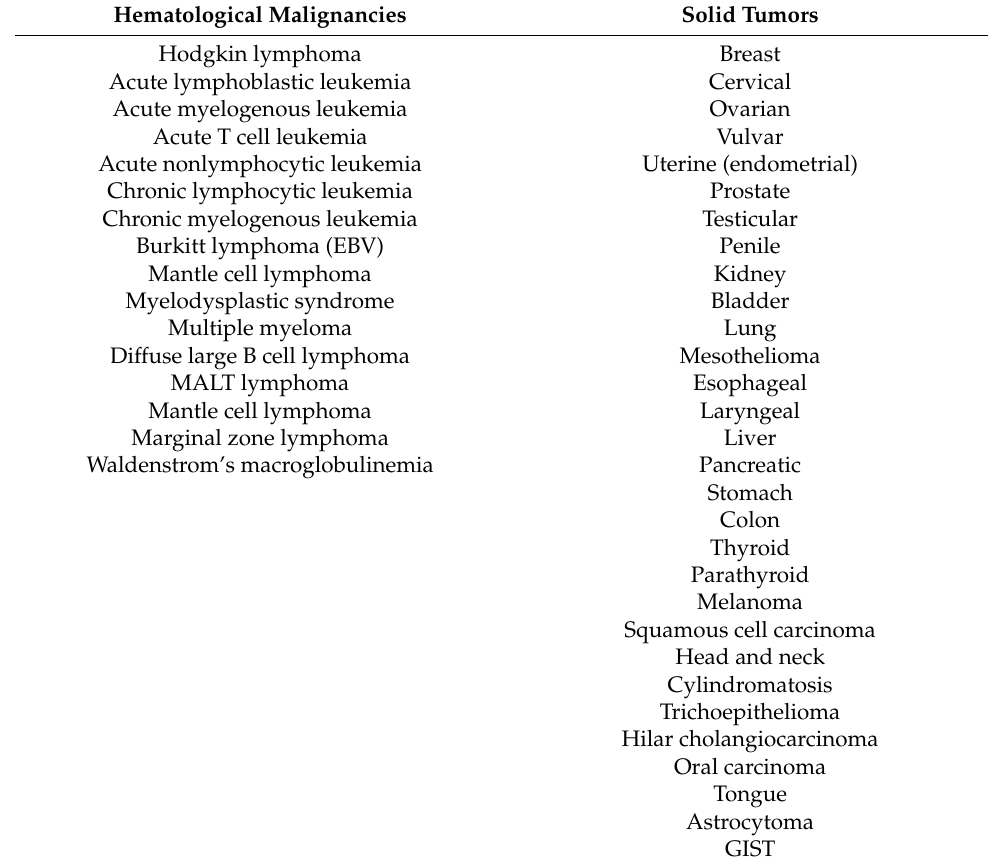
Stomach Colon Thyroid Parathyroid Melanoma Squamous cell carcinoma Head and neck Cylindromatosis Trichoepithelioma Hilar cholangiocarcinoma Oral carcinoma Tongue Astrocytoma